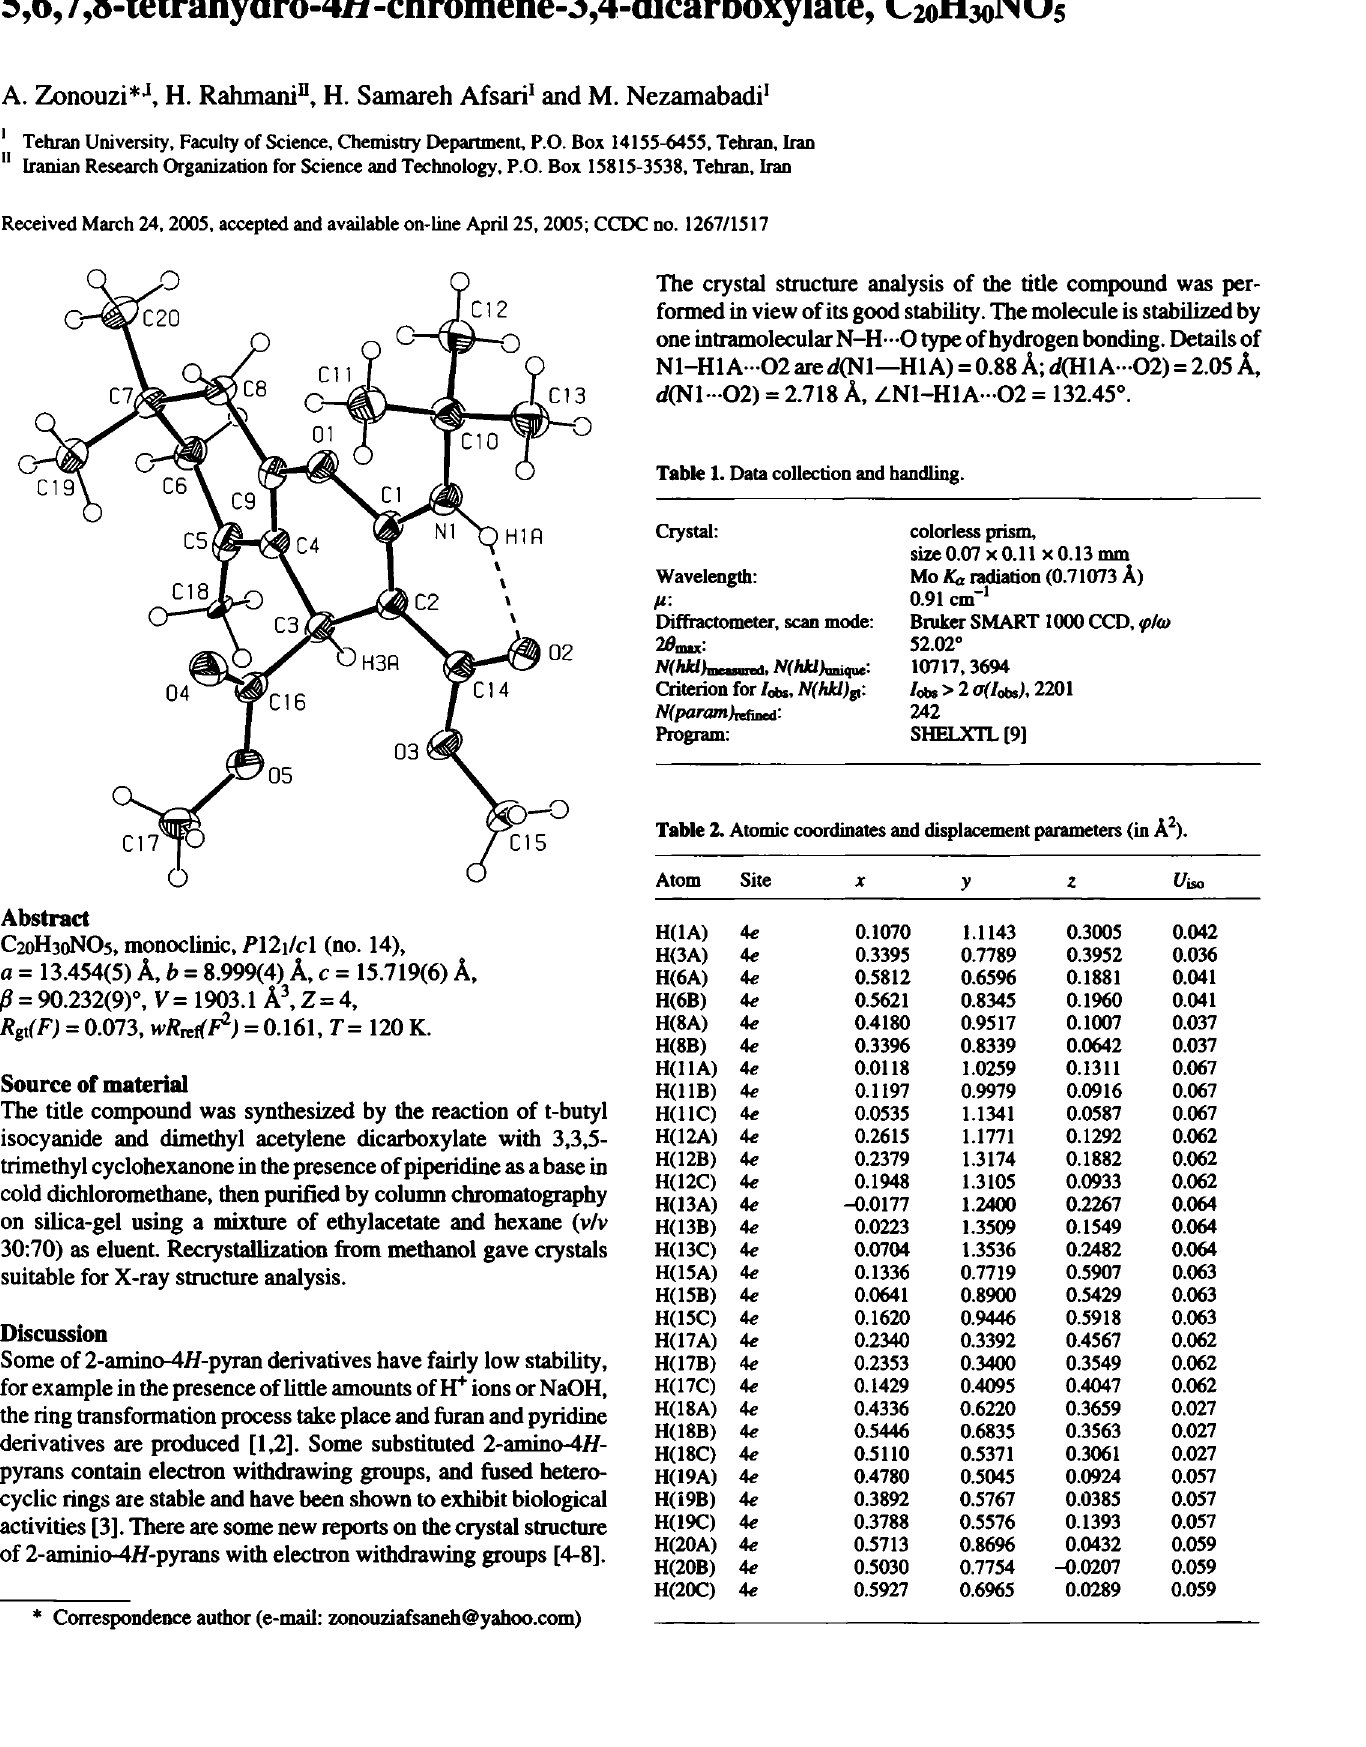
Table 1. Data collection and handling.